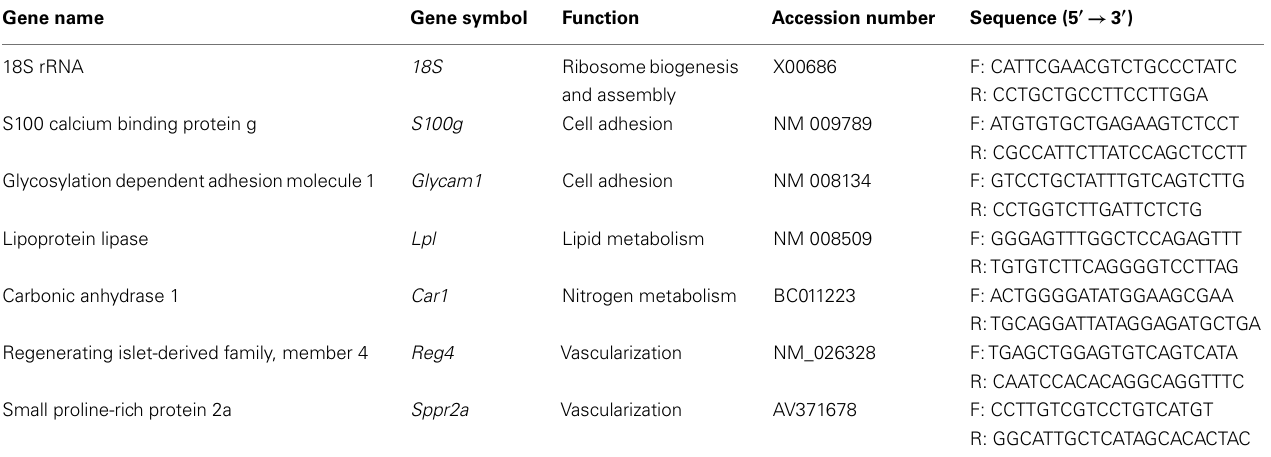
Table 1 | Primers sequences used in this study to validate arrays